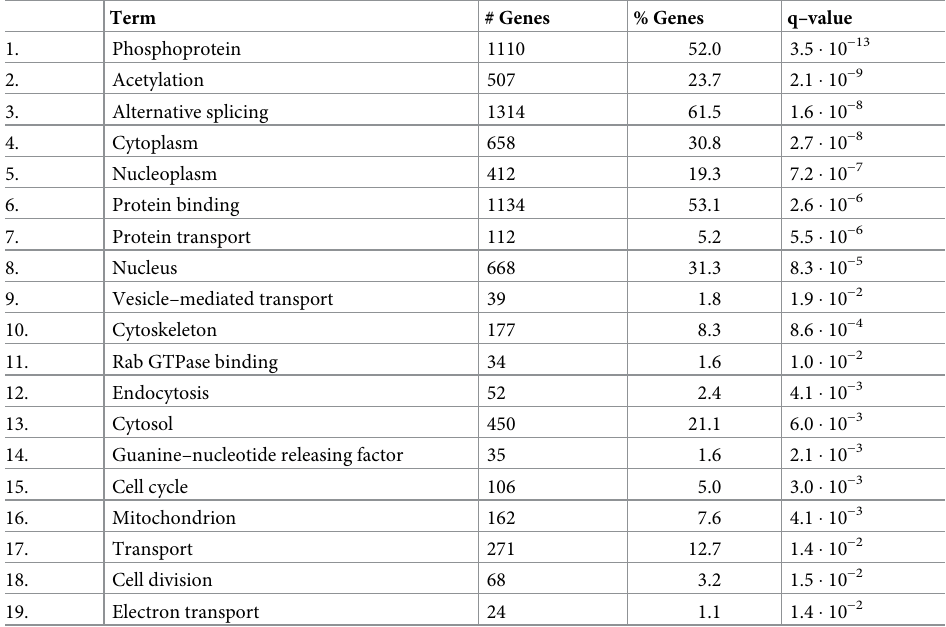
Table 2. Functional annotation of genes with a CpG at TSS position −